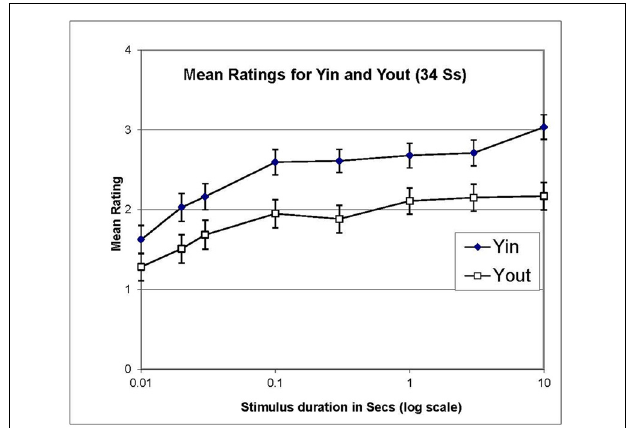
FIGURE 4 | Mean ratings of illusion strength in Experiment 2, for Yin and Yout, averaged over recognizers and non-recognizers and plotted against stimulus duration in log s. Error bars show ± 1 standard error of each mean.